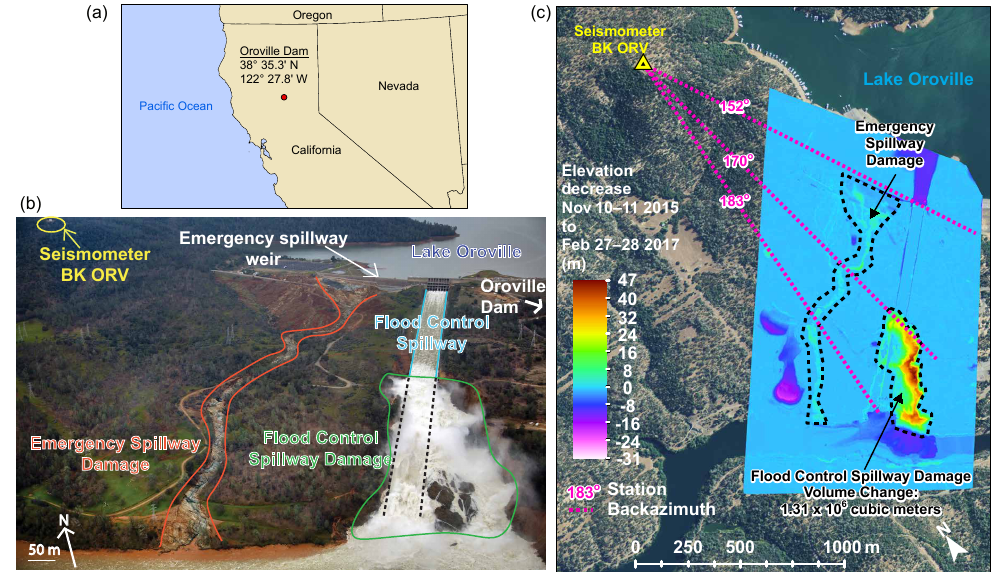
Figure 1. (a) Location of the Oroville Dam in northern California. (b) The damage created along the flood control and emergency spillways of Oroville Dam in February and March, 2017. The seismometer used in this study is located approximately 2km from the spillway. Photo credit: Dan Kolke, Department of Water Resources. Image taken on 15 February 2017. Estimated discharge during photograph is 2800m 3 s − 1 . (c) A digital elevation model created from lidar points provided by the California Department of Water Resources. The elevation difference from a November 2015 elevation survey and a late February 2017 survey shows that the crisis incised a chasm up to 47m deep. The volume of the main chasm is 13 × 10 6 m 3 . The incision resulting from the use of the emergency spillway is less than 20m deep. The back-azimuth (clockwise from north) in degrees is displayed for the top of the flood control spillway, the top of the chasm, and the bottom of the flood control spillway. The seismometer is at an average 13 ◦ slope above the base of the flood control spillway and an average 8 ◦ slope above the top of the flood control